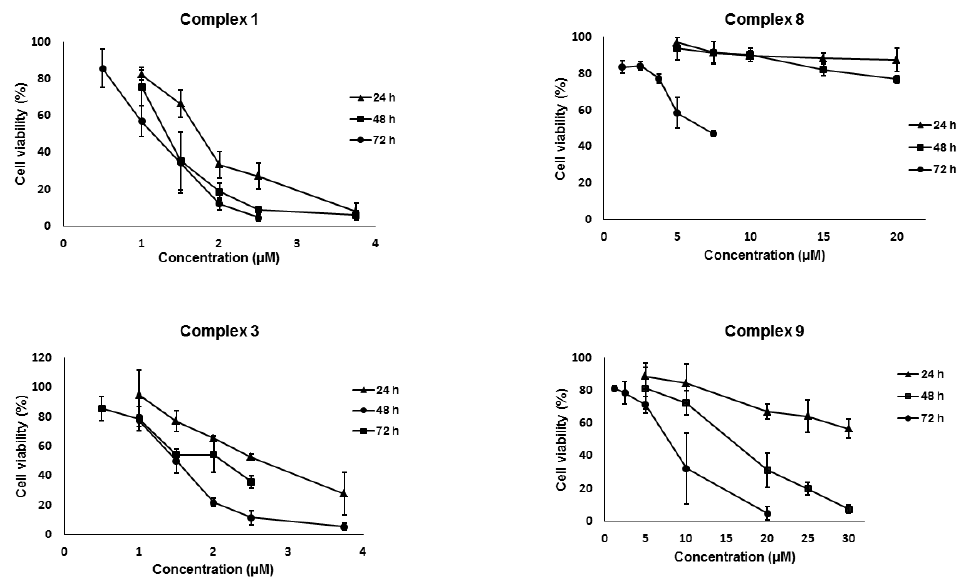
Figure 2. Dose–response curves of the Caco-2 cell viability percentage of metal complexes at different concentrations and incubation times. Table 3. IC 50 values obtained after treating Caco-2 cells with complexes 1 , 3 , 8 and 9 at incubation times of 24, 48 and 72 h.